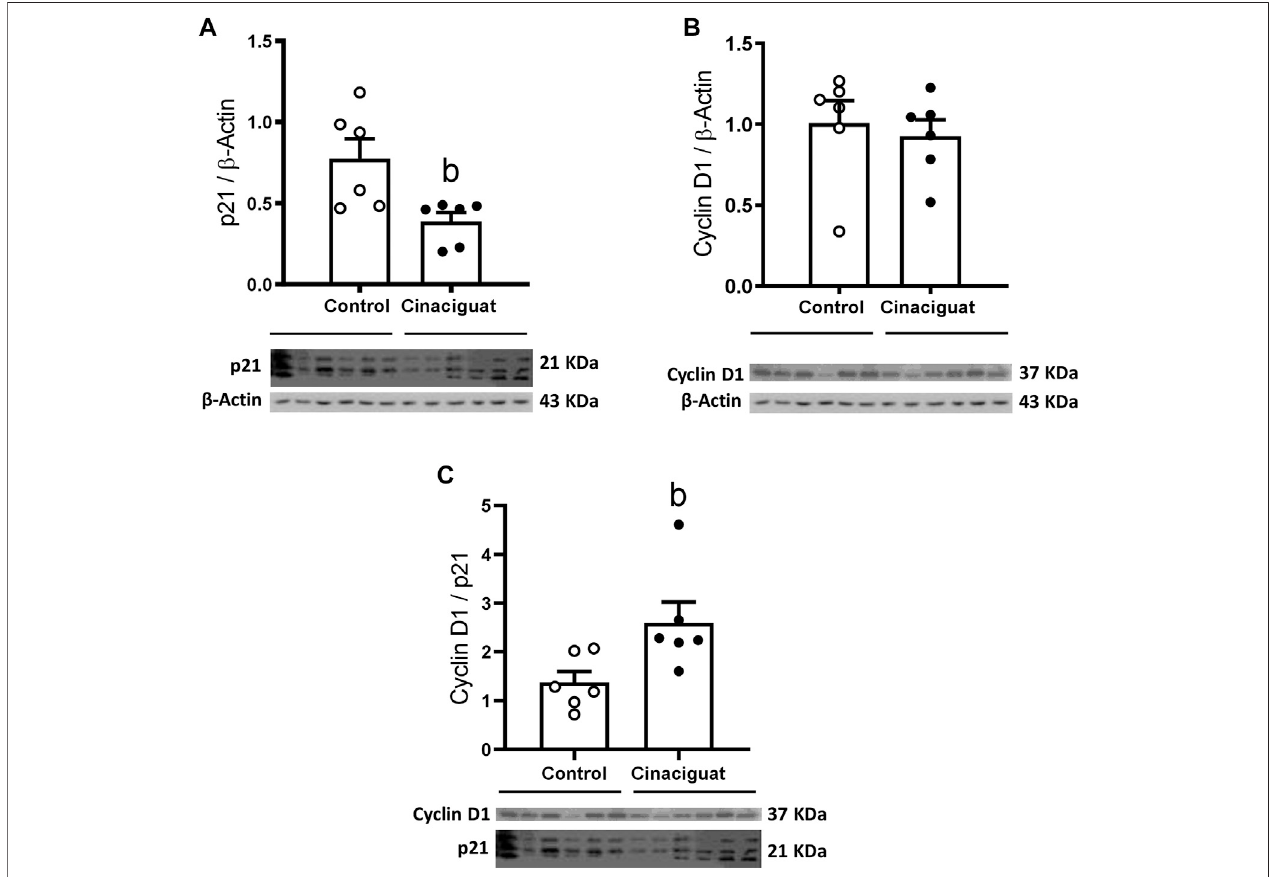
FIGURE7| EffectofCinaciguattreatmentonpulmonaryproteinexpressionofcellproliferationmarkersinchronicallyhypoxicandpulmonaryhypertensiveneonatal lambs. WB of p21/ β -Actin (A) , Cyclin D1/ β -Actin (B) , and Cyclin D1/p21 ratio (C) . The β -Actin image was re-used for illustrative purposes. Control (Open circles, n = 6) and Cinaciguat-treated lambs (Black circles, n = 6). Values are means ± SEM. Signi fi cant difference ( p ≤ 0.05): b vs. Control group.